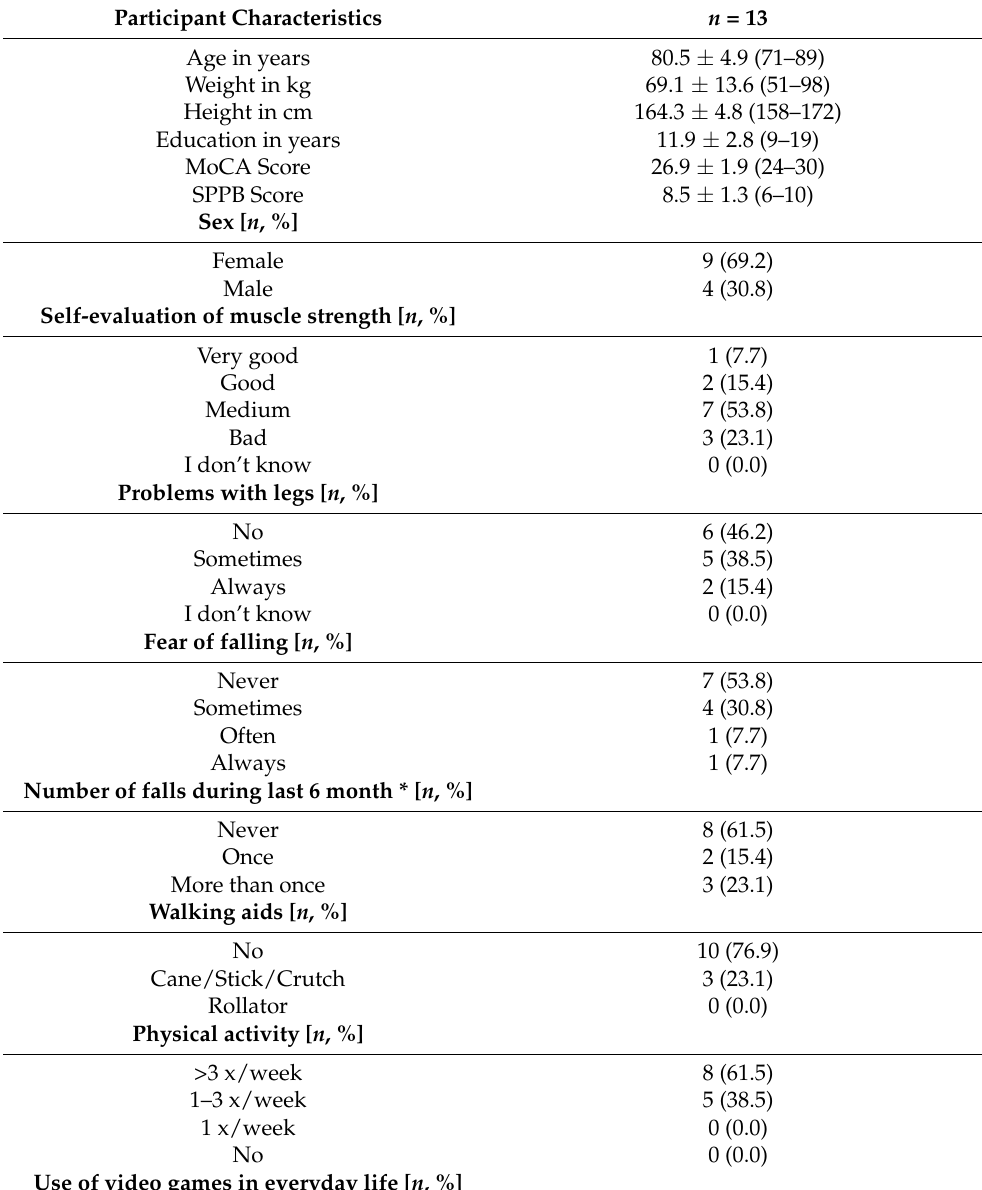
Table 1. Baseline demographic characteristics of participants and screening